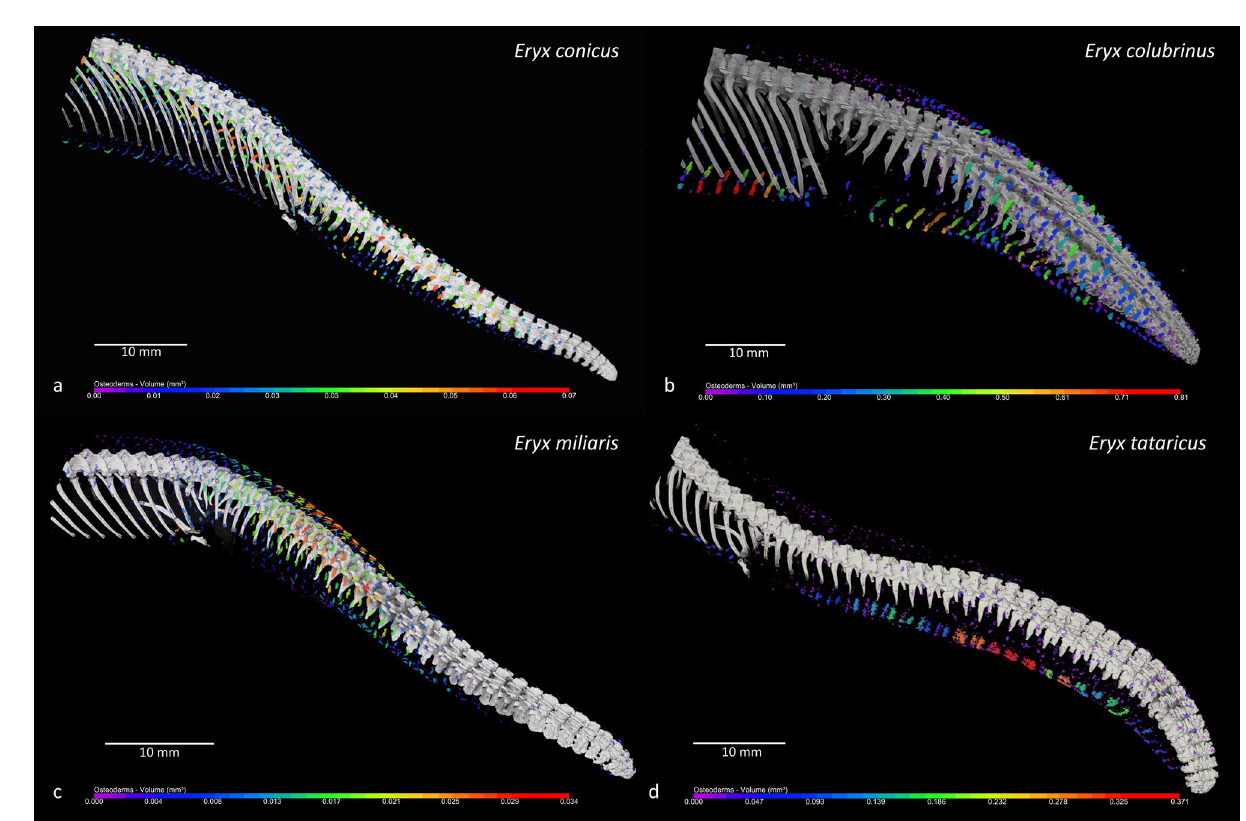
Figure 2. Visualisation of the caudal part of the body and tail of the sand boas by µCT. ( a ) Eryx conicus , ( b ) E. colubrinus , ( c ) E. miliaris , ( d ) E. tataricus . The small, coloured structures are osteoderms, which are present on the tail and the caudal part of the body anterior to the cloaca. Colours are according to the volume (in mm 3 ) of osteoderms. Note the different scales of volume for each species. Osteoderms do not cover the body continuously; rather they are individually distributed across the surface inside the skin. The distribution of osteoderms is regular resembling the distribution of scales. Bar 10 mm. Author: Petra Frýdlová and Jan We propose an antipredatory function of osteoderms in sand boas based on (1) the caudal distribution on the body, (2) fossorial ecology, and (3) the caudal vertebrae modifications. Sand boas are fossorial snakes with rather short, stout bodies. The tail resembles the head, which, in combination with the tail displays, causes the attention and attacks of predators to be directed to this less vulnerable part of the body, the tail. This was